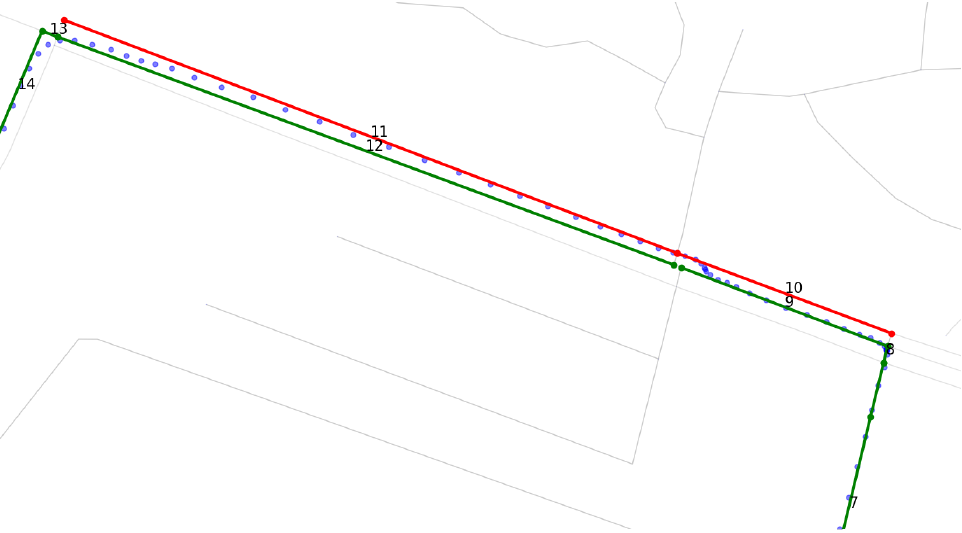
Figure 12. Model outcome for Cat-IV error : identified ambiguous lane in Dataset 6. Table 1. Model performance validation with the GeoLife datasets